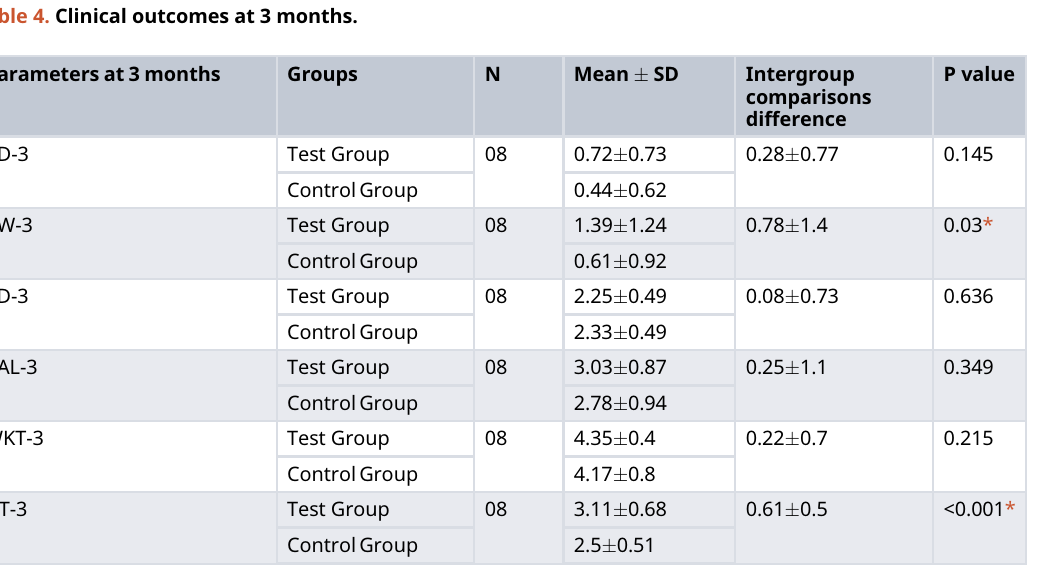
Table 4. Clinical outcomes at 3